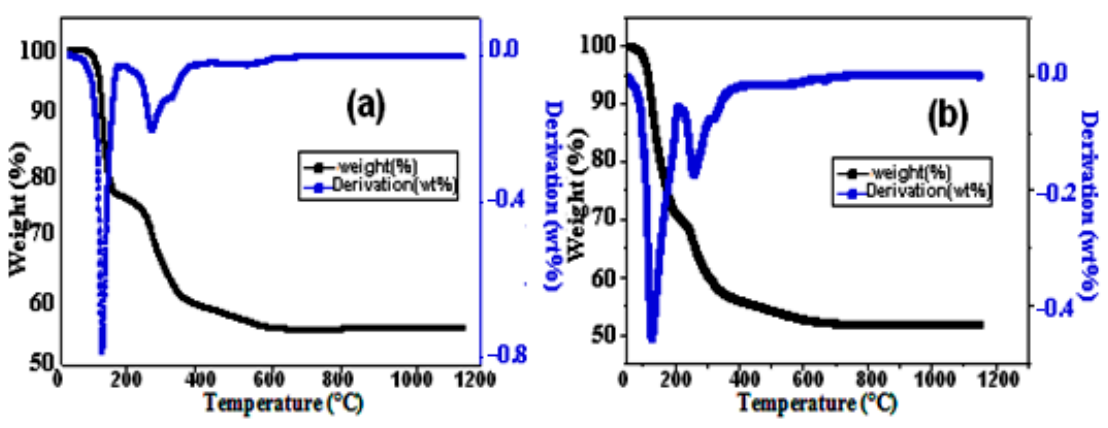
Figure 3. TGA curve of pure ( a ) and H 2 O 2 ( b ) cements.